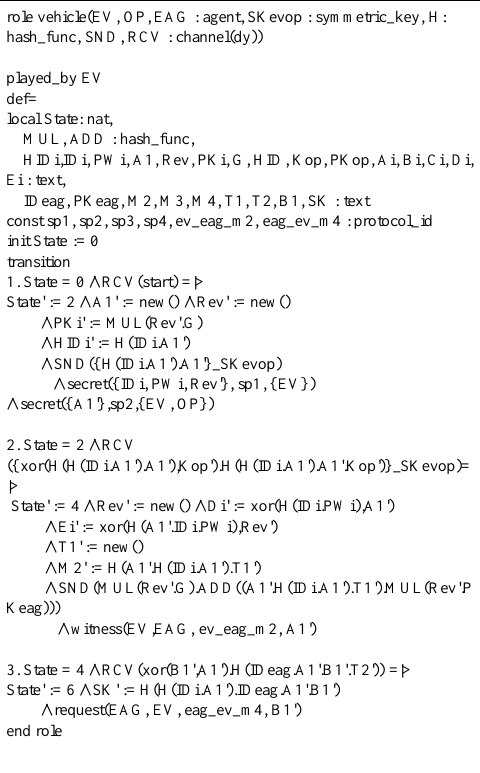
Figure 9. Code of